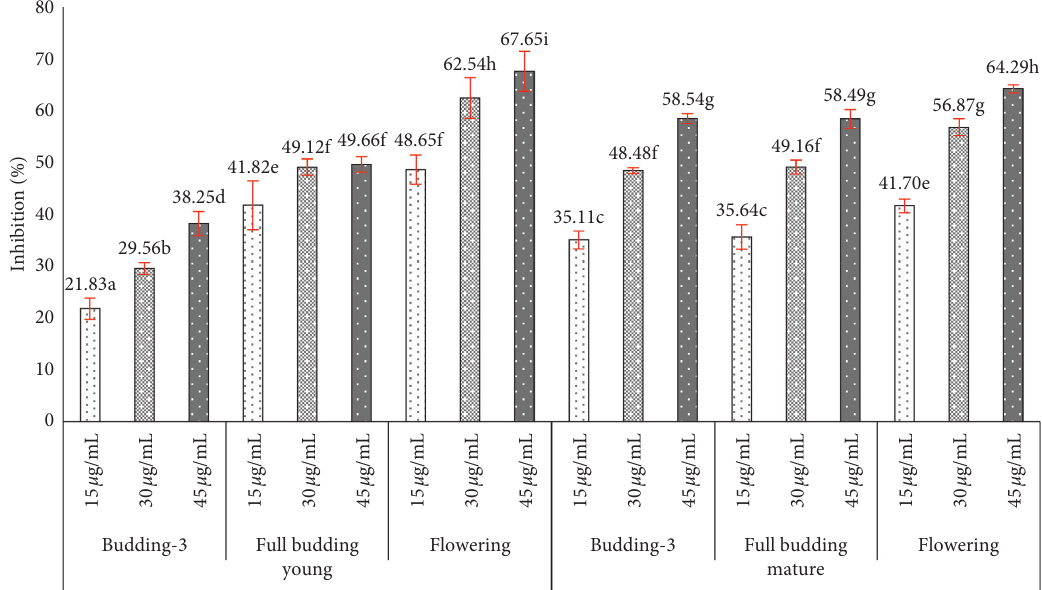
Figure 2: DPPH radical inhibition (%) of clove oil at different ages, phenological stages, and concentrations from three replications ( p < 0.05).